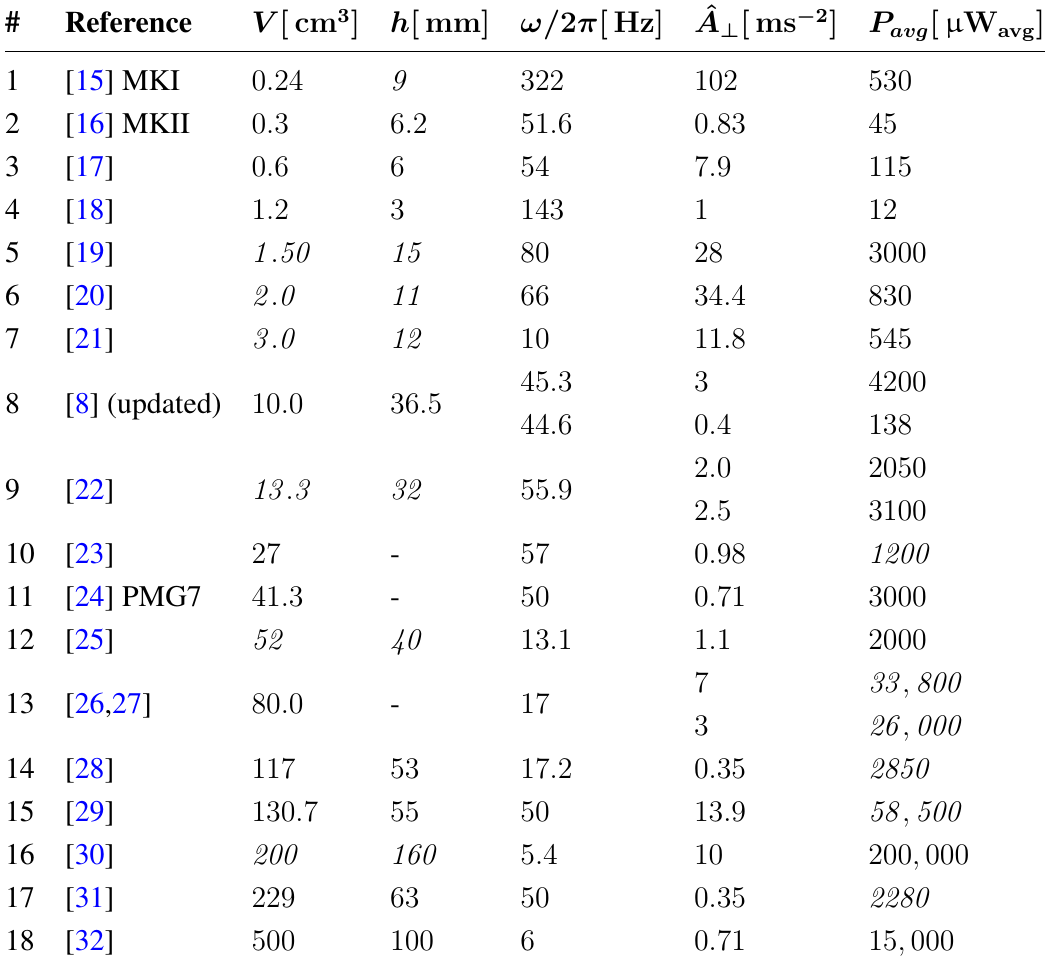
Table 1. Harvester parameters corresponding to Figure 3 estimated / cited from published values. Multiple values are provided if maximum performance at different BPs is based on different measurements. If measured power was rectified, a compensation factor of 1 . 3 was